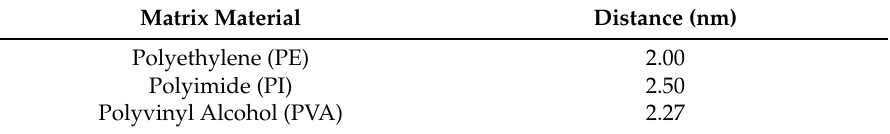
Table 1. Minimum distances for tunneling paths. All values taken from Sun et al.